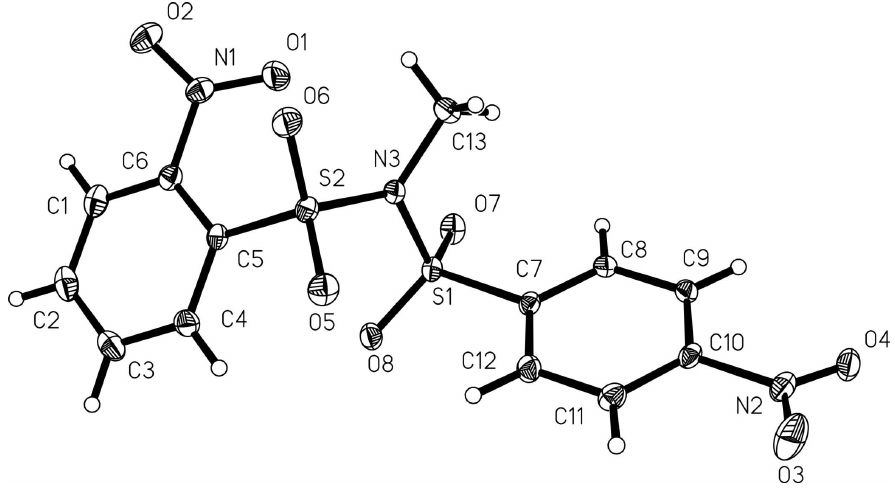
Figure 1 The molecular structure of the title compound, with the atom-labelling scheme. Displacement ellipsoids are drawn at the 40% probability level.